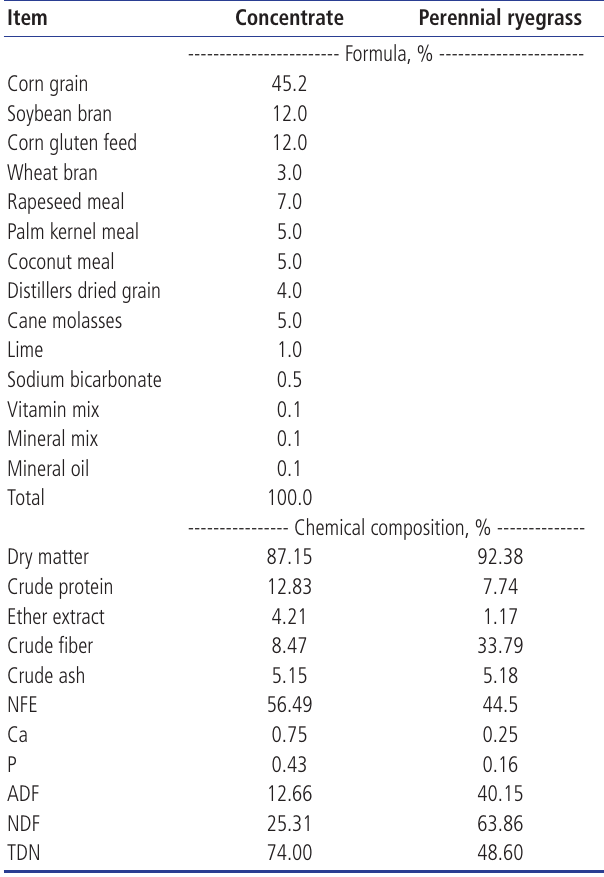
Table 1. Chemical compositions of concentrate and perennial ryegrass fed to finishing Korean cattle (Hanwoo) steers Item